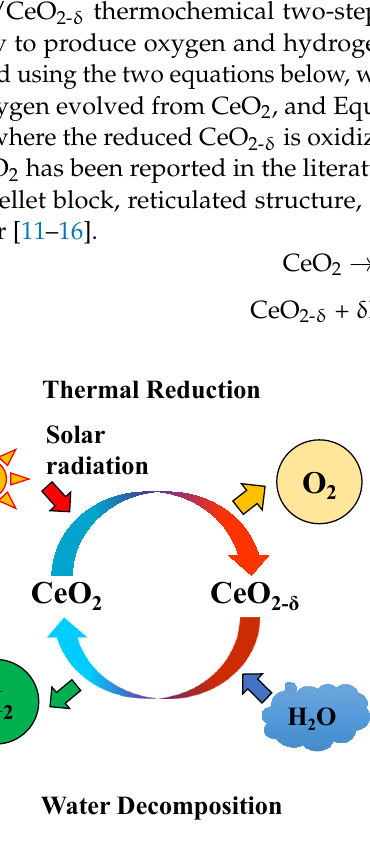
Figure 1. Schematic diagram of solar-driven thermochemical two-step water-splitting cycle from non-stoichiometric ceria.